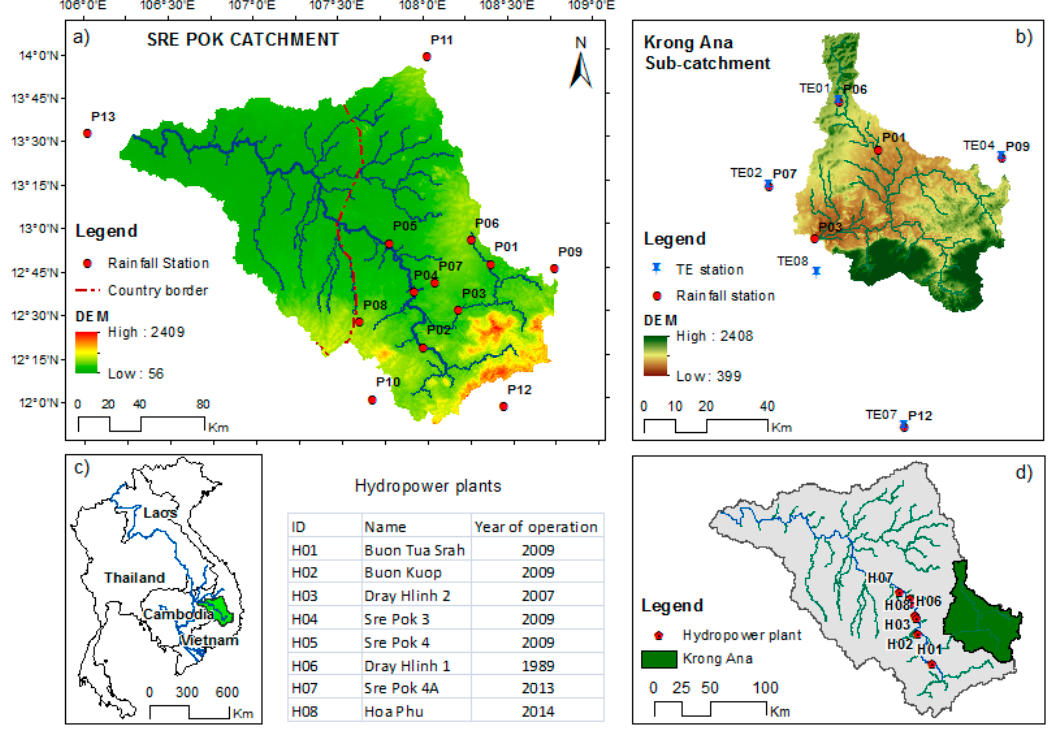
Figure 1. Study areas: ( a ) Sre Pok catchment; ( b ) Krong Ana sub-catchment; ( c ) location of the Sre Pok catchment in the Lower Mekong river basin; and ( d ) location of the Krong Ana sub-catchment in the Sre Pok catchment; TE: temperature and evaporation.